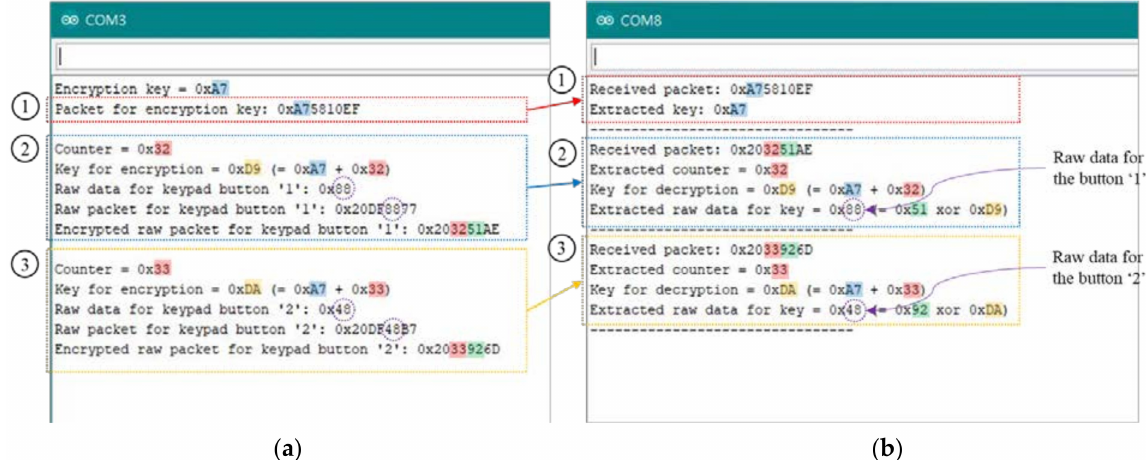
Figure 19. Log messages from transmitter and receiver in Figure 18: raw, encrypted, and decrypted data for keypad buttons ‘1 (cid:48) and ‘2 (cid:48) with the encryption key and counter values. ( a ) Transmitter (in Figure 18)’s log messages. ( b ) Receiver (in Figure 18)’s log